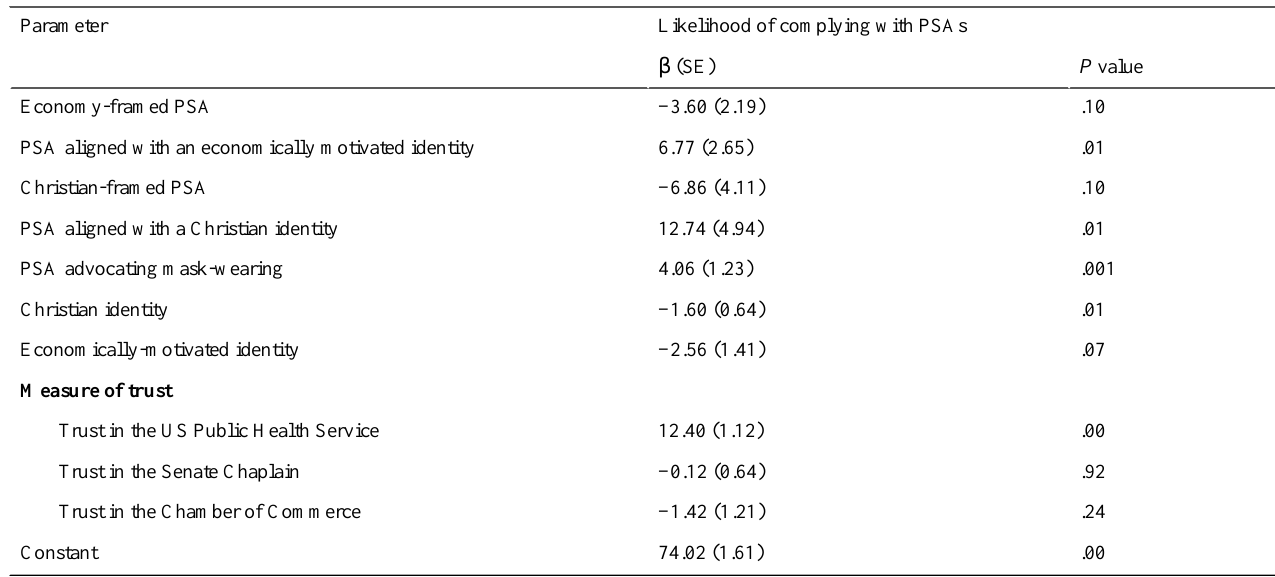
Table 2. Analysis results with beta coefficients ( β ) for identity-framed public service announcements (PSAs) and information-based control PSAs (584 observations; 292 participants; R 2